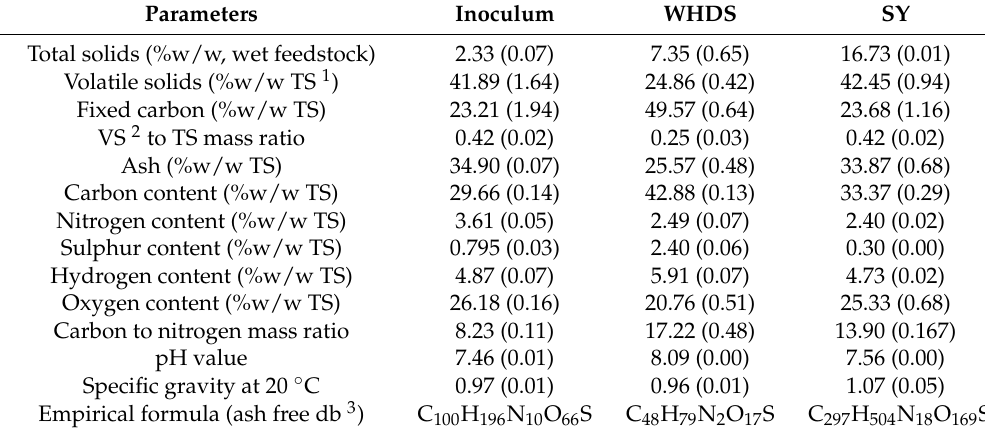
Table 1. Characterization of the WHDS (wet hydrolyzed DAF sludge), SY (stockyard) waste and